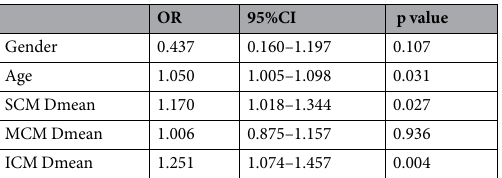
Table 4. Results of binary logistic regression for grade 0–1 and grade 2 late dysphagia patients.